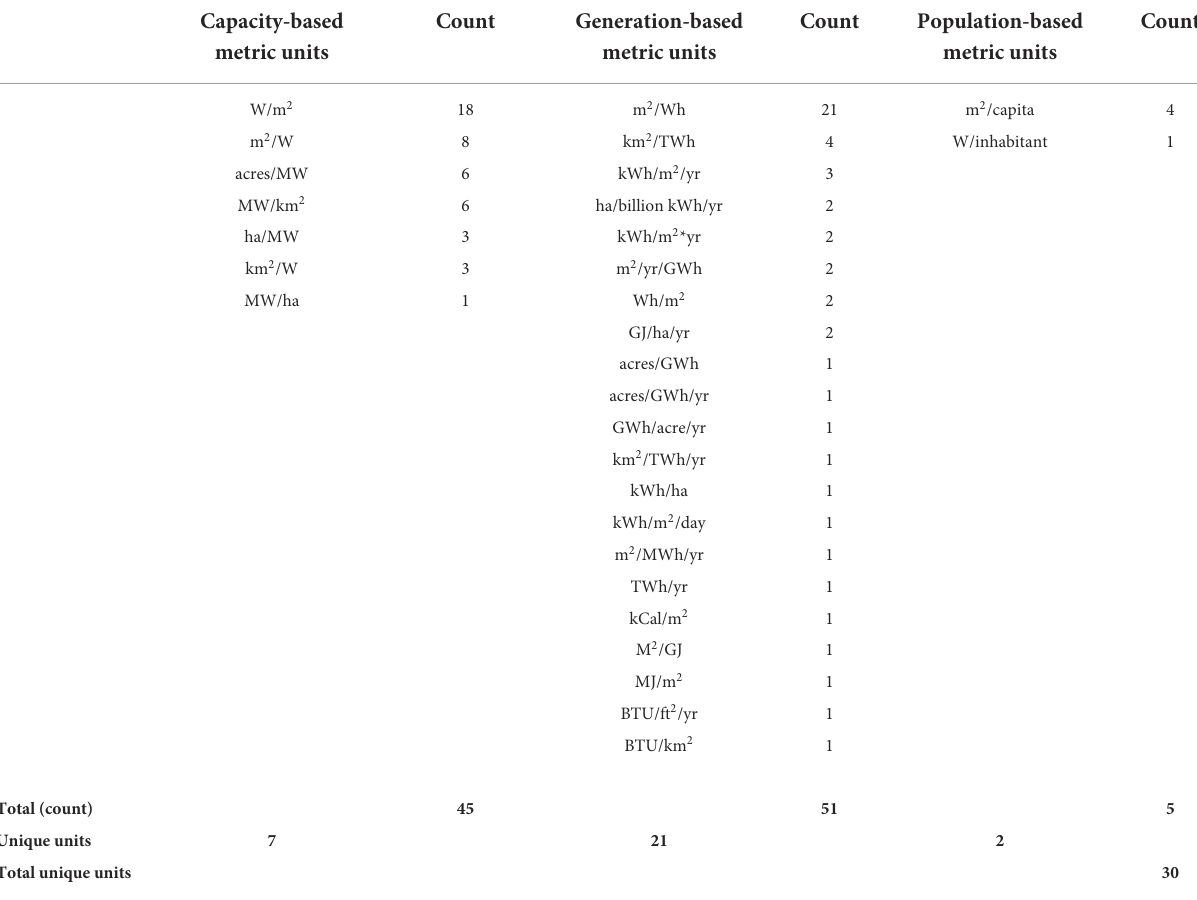
TABLE 1 Classification of metric units documented in the literature on solar energy-land relationships.